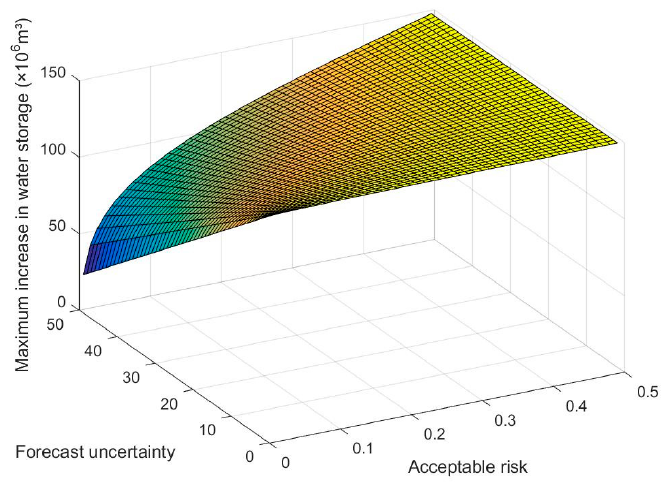
Figure 9. The relationship between the maximum increase in storage capacity, acceptable risk, and forecast uncertainty.